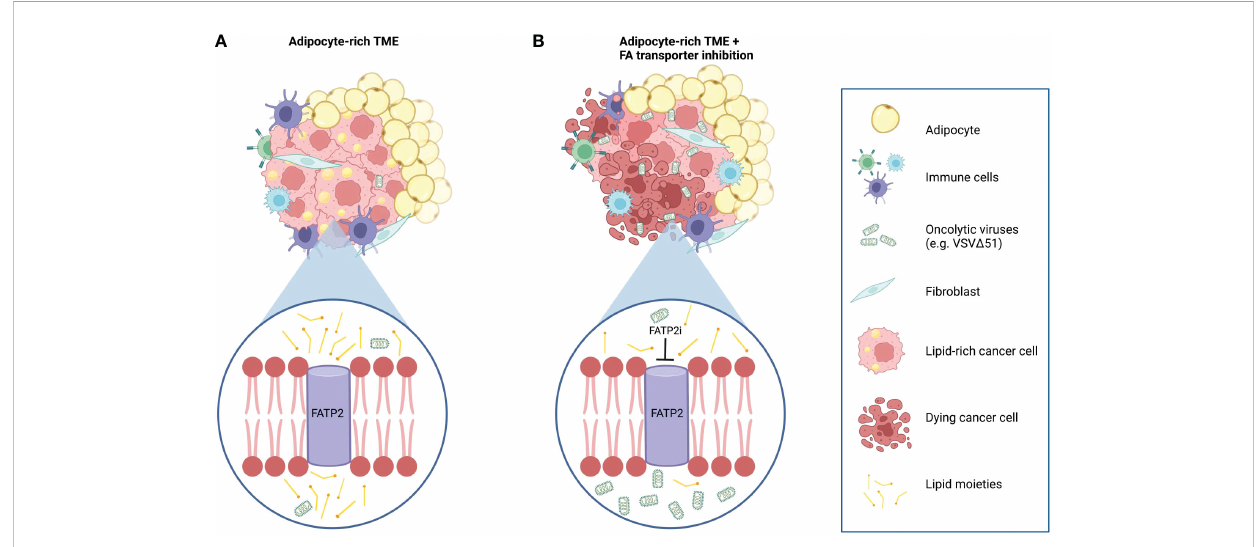
FIGURE 5 Working model of the effects of adipocyte-derived lipids on OV resistance and the OV sensitizing effects of combination therapy with FATP2 inhibition. (A) Tumors in an adipocyte-rich microenvironment accumulate intracellular lipids that lead to a decreased sensitivity to oncolytic virus infection and cancer cell killing. (B) Intracellular lipid accumulation can be mitigated by blocking the uptake of exogenous adipocyte-derived lipids by depletion of the lipid-derived constituents in the ACM or by using speci fi c inhibitors to block the activity of fatty acid transporter proteins, such as FATP2. For example, Lipofermanta, a speci fi c FATP2 inhibitor, can re-sensitize cancer cells to OV infection and virotherapy-mediated cell